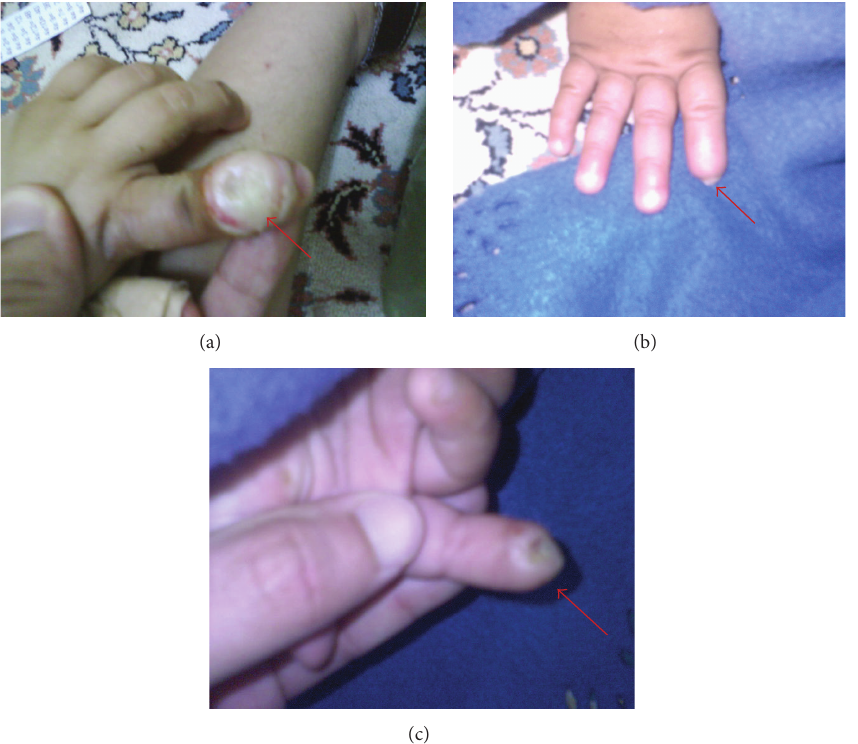
Figure 2: (a) Photograph at age two, showing self-inflicted traumatic ulcer due to biting. (b) Photograph at age four, showing self-amputation of the terminal phalanges of the right index finger from dorsal aspect. (c) Photograph at age four, showing self-amputation of the terminal phalanges of the right index finger from ventral